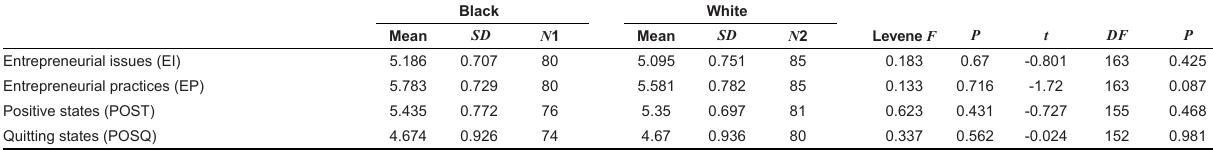
TABLE 12 t -test: Comparison of cultural groups in respect of entrepreneurship